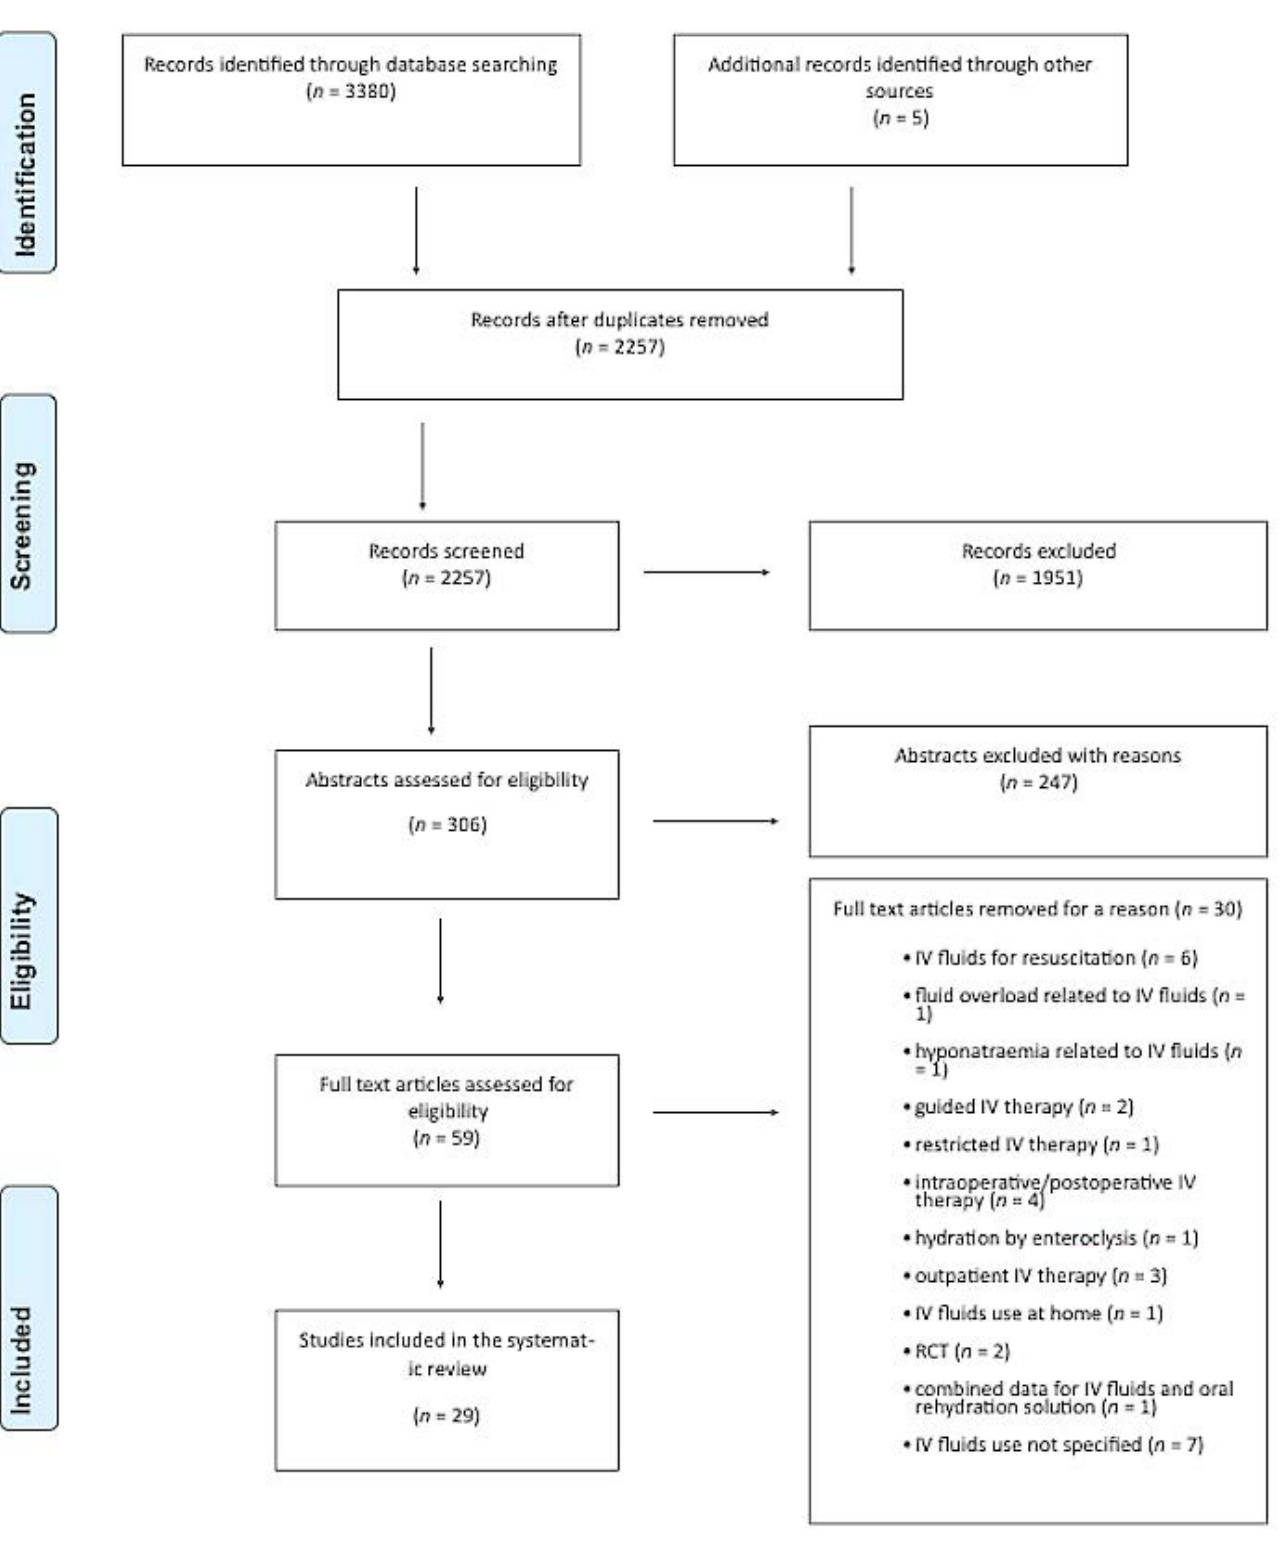
Figure 1. PRISMA flow diagram illustrating article